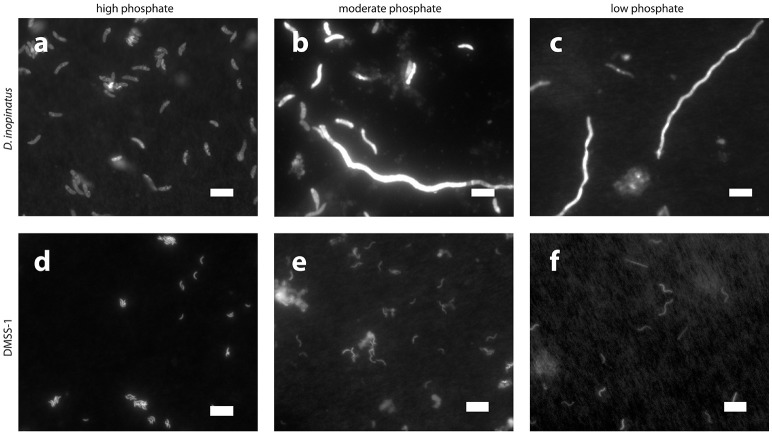
Epifluorescence photomicrographs of cultures grown on lactate in the presence of different concentrations of phosphate. Top row, D. inopinatus in (a) 1,500 μM PO43− (12.9 days); (b) 15 μM (14.7 days); and (c) <1 μM (8.0 days). Bottom row, DMSS-1 in (d) 360 μM PO43− (6.1 days, see also Figure 1c for inset); (e) 5 μM (13.0 days); and (f) <1 μM (42.8 days). Scale bars represent 10 μm. Panels (b,c,f) show long chain-like single cells.